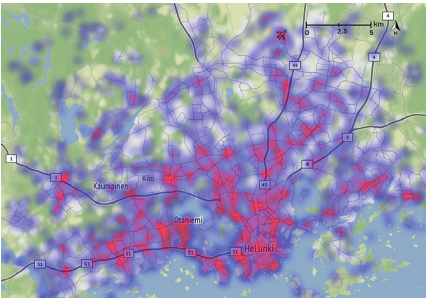
Figure 6: Spatial distribution of the observed trips illustrated by density map of origins/destinations. Blue color represents lower density and red color represents higher density. The map shows the Helsinki metropolitan region including cities of Helsinki, Espoo, and Vantaa (map copyright of OpenStreetMap, under ODbL).